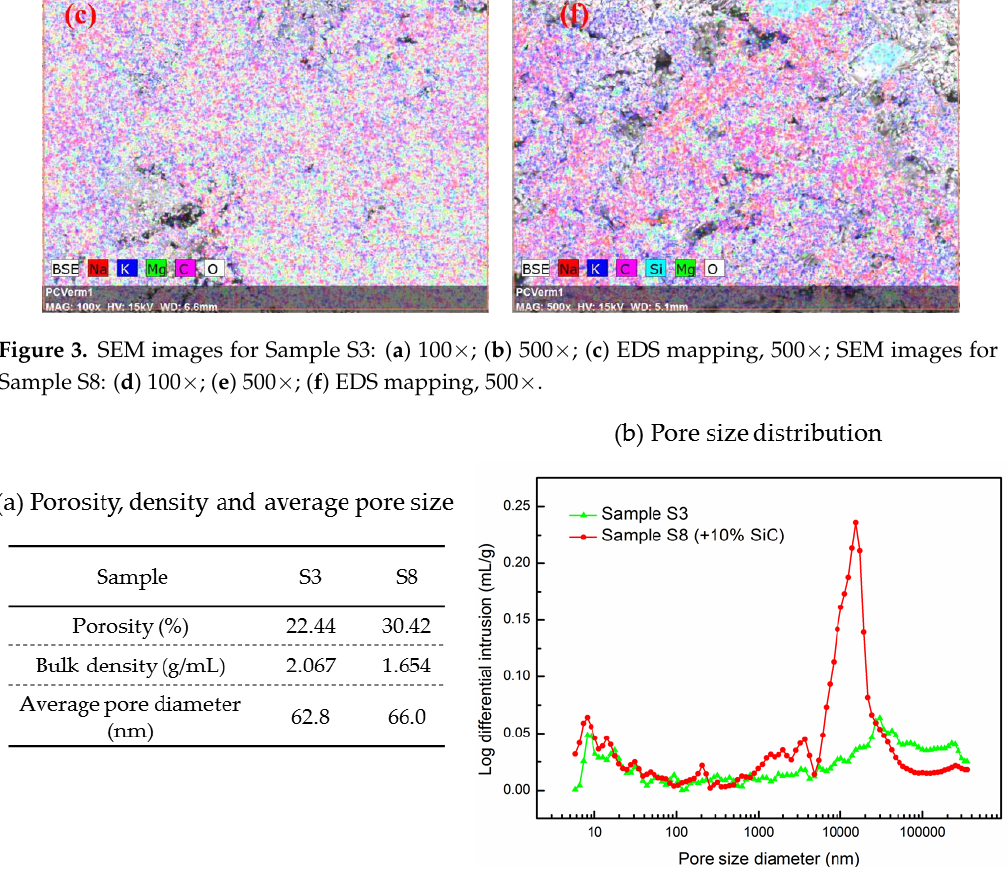
Figure 4. Pore size, porosity, and density of Sample S3 and Sample